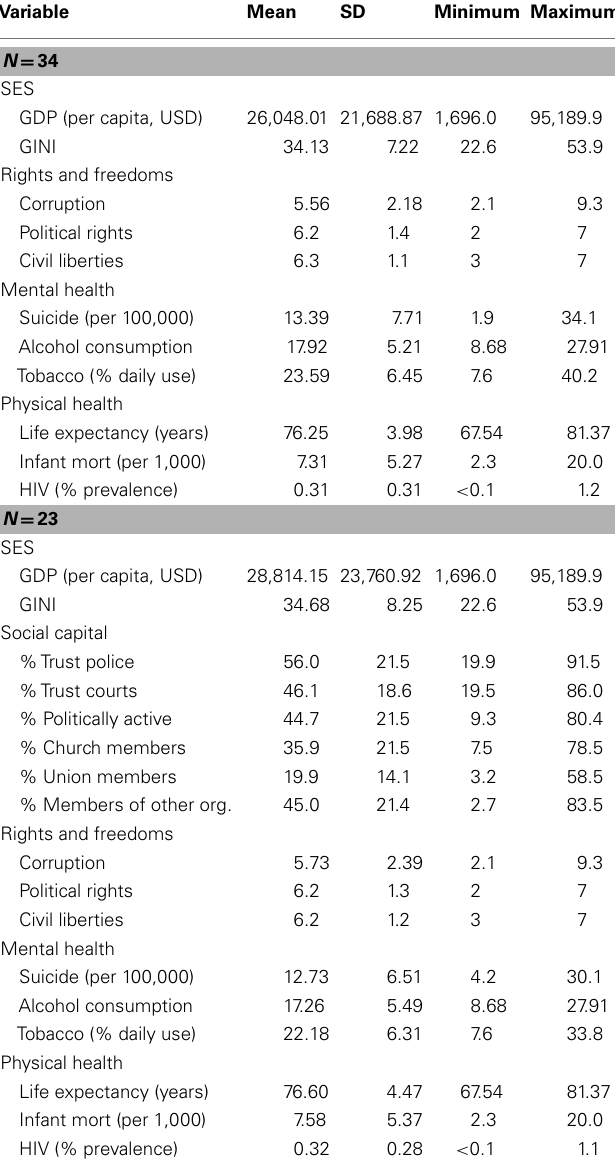
Table 1 | Descriptive statistics N s = 34 and